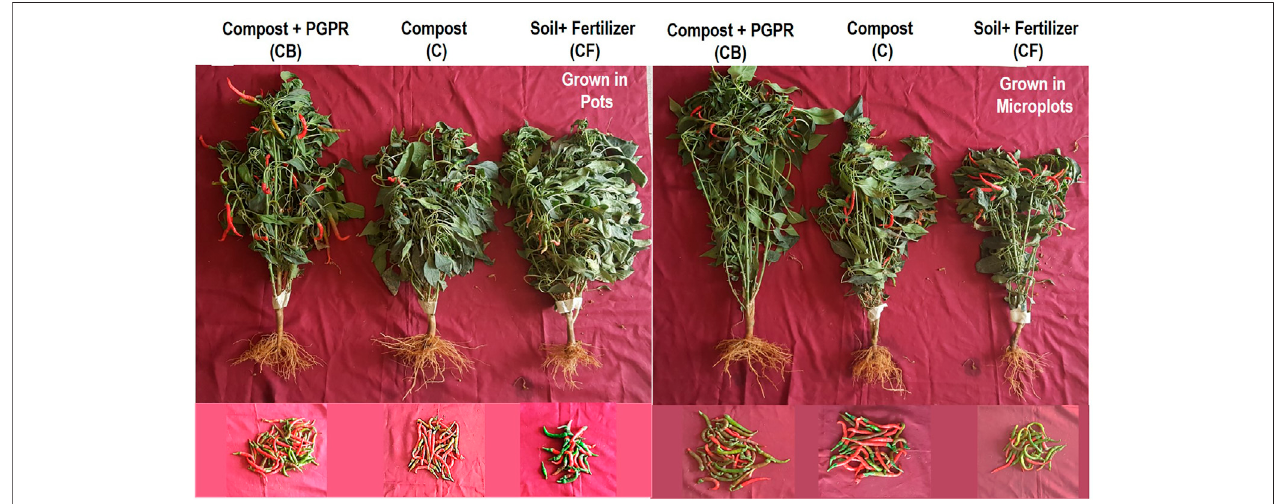
FIGURE 5 | Response of compost and PGPR inoculum on chilies growth and total yield per plant in pots and microplots compared with that grown in soil with chemical fertilizers.